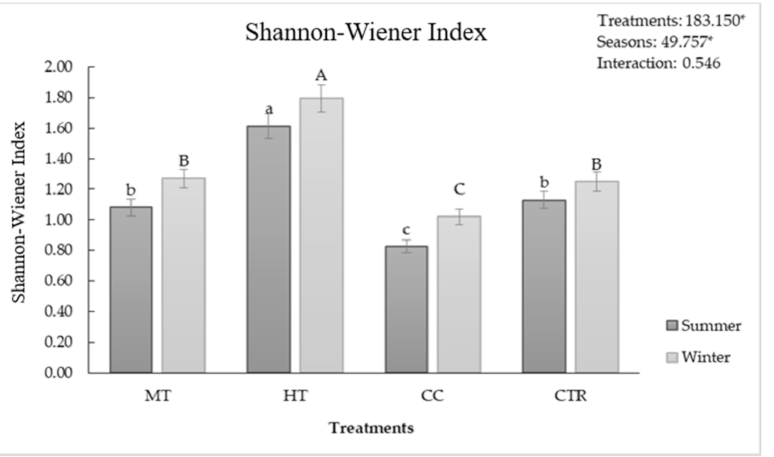
Figure 4. Shannon–Wiener Index of diversity in soil under differently managed plots in a Pinus laricio plantation. HT: intensive thinning; MT: moderate thinning; CC: clear cut; and CTR: control. Two-way ANOVA shows the effects of treatments, seasons, and their interactions. Lowercase letters and capital letters show significant differences among the management intensities (Tukey’s test, p -level ≤ 0.05) in summer and winter, respectively. * p < 0.05. The data are the means of two consecutive years (2014 and